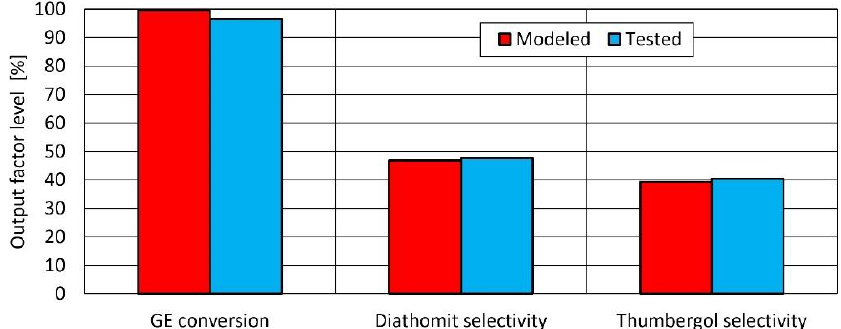
Figure 9. Comparison of modeled and tested output parameters of optimization.